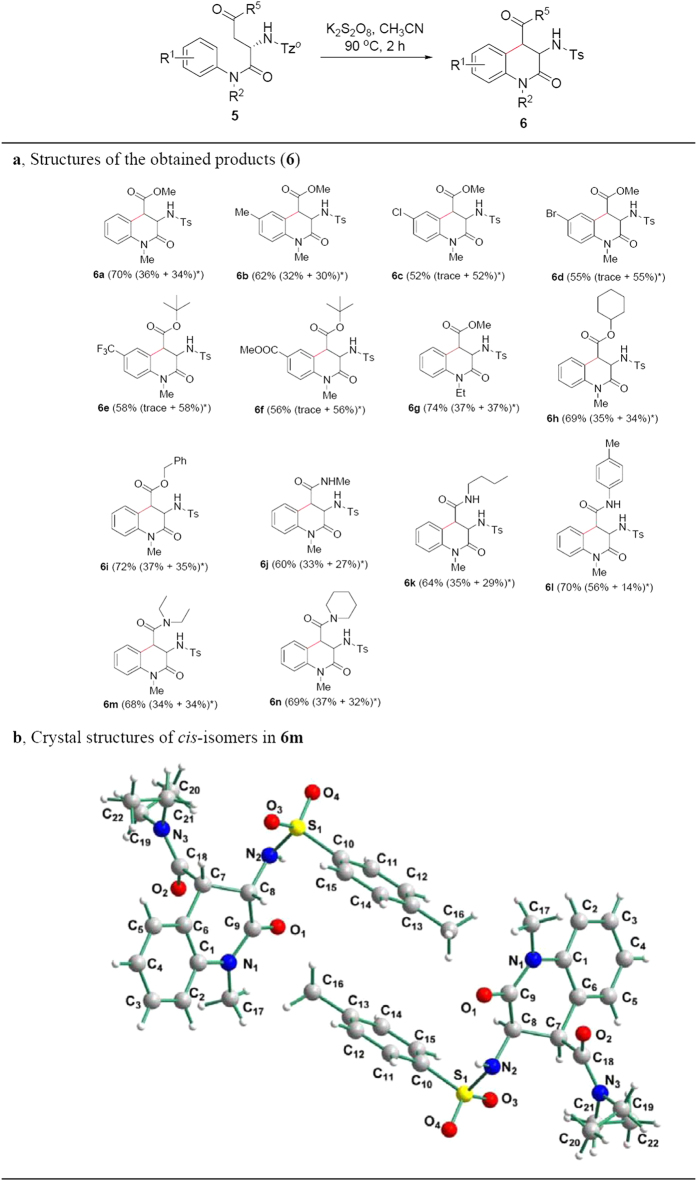
Substrate scope for couplings of α-C-H bond of carbonyl and aromatic C-H bond.(a) Structures of the obtained products (6). (b) Crystal structure of compounds 6m. Reaction condition: under nitrogen atmosphere, 5 (0.1 mmol), K2S2O8 (0.2 mmol), CH3CN (2.0 mL), reaction temperature (100 °C), reaction time (2 h) in a sealed Schlenk tube. *Isolated yield (cis- and trans-isomers were separated by silica gel column chromatography, and their structures were identified by 1H NMR analysis).